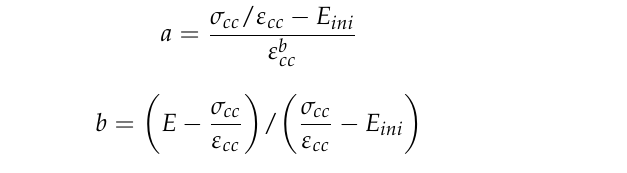
Figure 6. The strain equivalence hypothesis diagram.